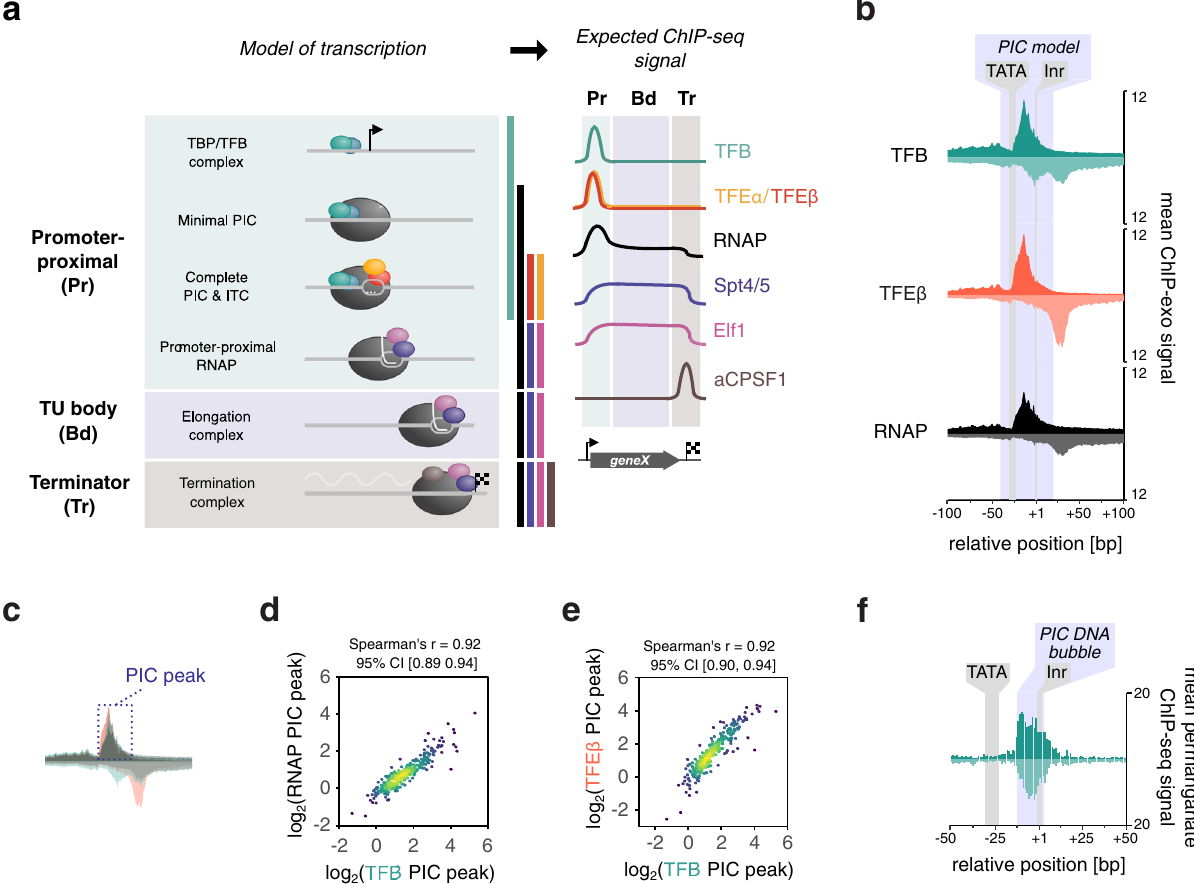
Fig. 1 Uniform PIC assembly during exponential growth. a Stages of transcription in archaea can be assessed by a combination of RNAP and basal transcription initiation and elongation factor occupancy. b Aggregate plots of ChIP-exo signal at the promoter for RNAP and initiation factors ( n = 298 TUs). The average signal on the non-template and template strand is shown above and below the line, respectively. Data are pooled from three biological replicates. c Schematic showing the 50-nt window on the non-template strand that we used to quantify and correlate the ChIP-exo signal. Because RNAP and initiation factors TFB and TFE β yield similar pro fi les on the non-template strand, this signal can be attributed to the PIC. d , e Scatter plots depicting correlation between the main ChIP-exo signal for TFB and RNAP ( d ) or TFE β ( e ) within the PIC ( n = 298). Data represent the average signal over a 50-nt window that we attributed to the PIC (see panel c ). The geometric mean of three biological replicates is shown. f Aggregate plots of permanganate ChIP- seq signal at the promoter for initiation factor TFB ( n = 298 TUs). The average signal for T-encoding positions on the non-template and template strand is shown above and below the line, respectively. Data are pooled from two biological replicates.